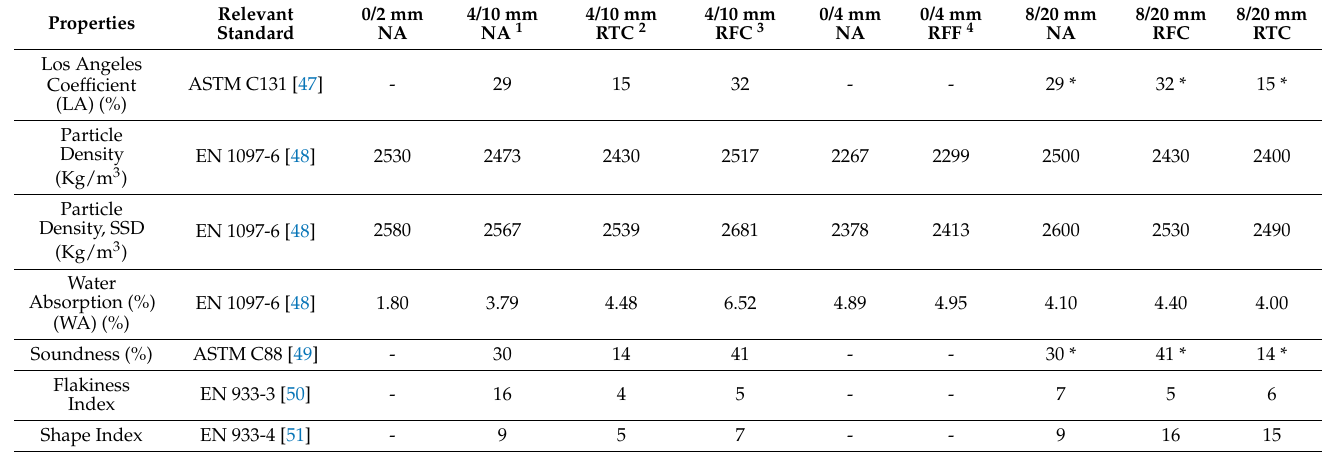
Table 1. Characterization of aggregates used in the experimental